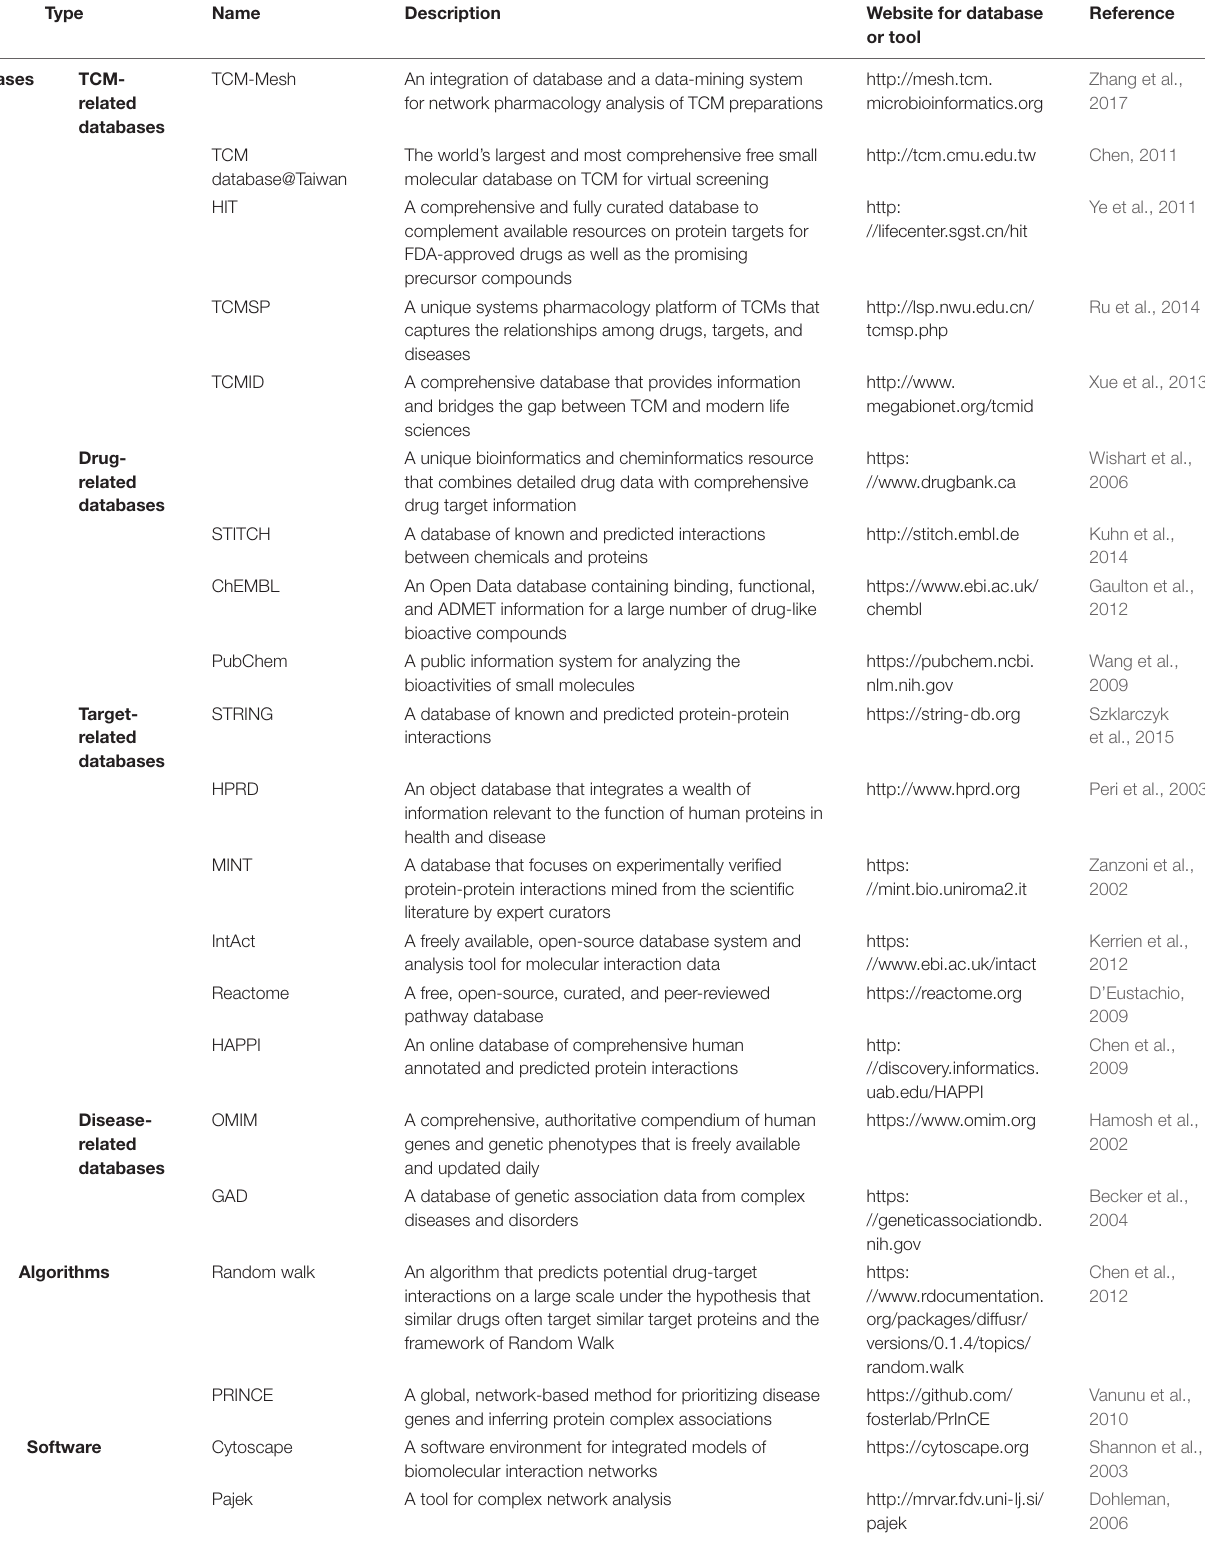
TABLE 1 | Public databases, algorithms, and software related to TCM network